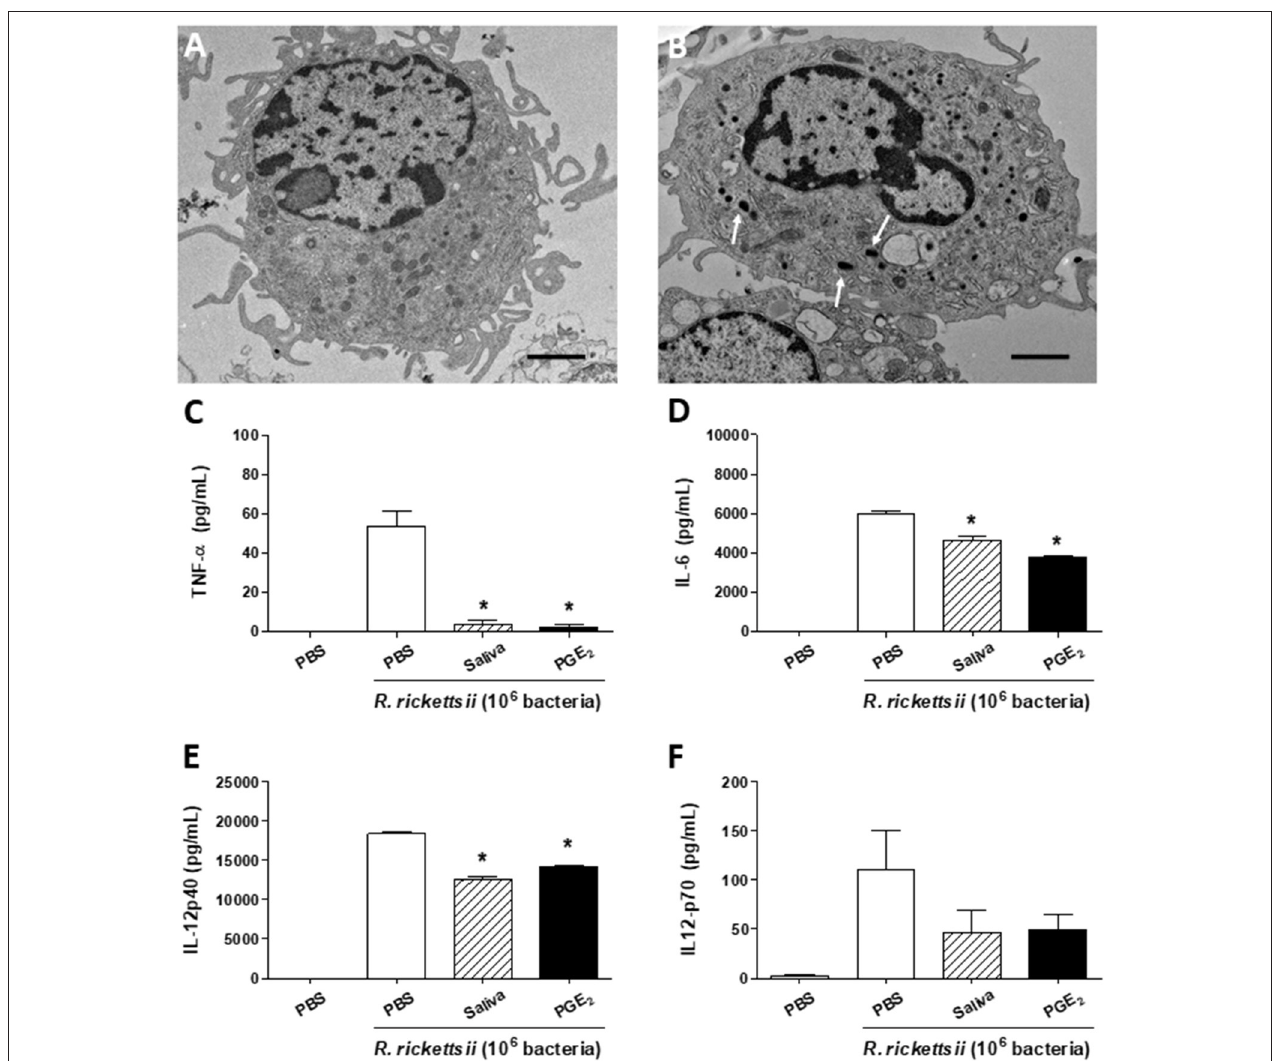
FIGURE 4 | A. sculptum saliva and PGE 2 downmodulate inflammatory cytokines produced by murine DCs incubated with R. rickettsii . Bone marrow cells from C3H/HePas mice were differentiated into DCs and used in the following assays. Transmission electron microscopy of a resting DC (A) and a R. rickettsii -infected DC (B) , showing the bacteria in the cytosol (white arrows). Non-adherent cells were collected, seeded at 10 5 cells/well in 96-well plates and preincubated for 1h with medium only, with A. sculptum saliva collected by pilocarpine stimulation from female ticks fed on host for 7–9 days (1:50 dilution) and PGE 2 (100nM). Cells were incubated with R. rickettsii (10 6 bacteria) during 6h for TNF- α (C) or 18h for IL-6, IL-12p40, and IL-12p70 ( D–F , respectively) determination in culture supernatants by ELISA. Results are expressed as the mean ± SEM. * p ≤ 0.05 vs. “DC + R. rickettsii /PBS” group. Scale bar = 2 µ